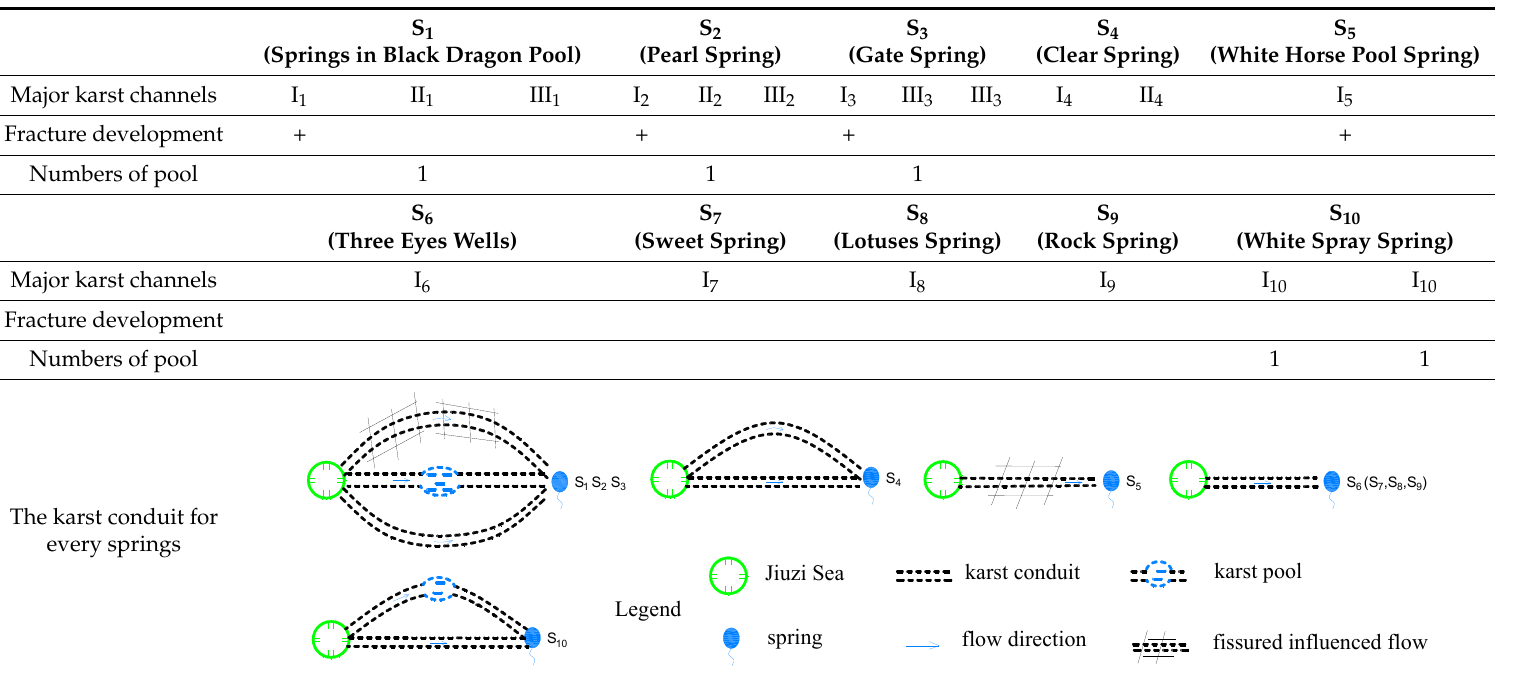
Table 6. Spatial characterizations of the karst conduits for every receiving spring.